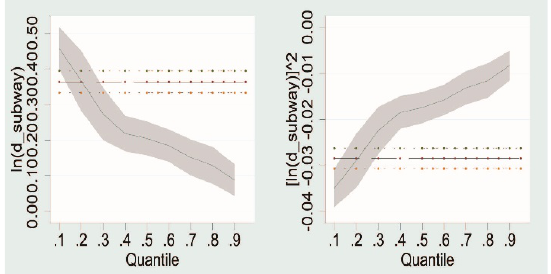
Figure 2. Changes of coefficients of d1-d6 in different quantile regression results in Equation (8).